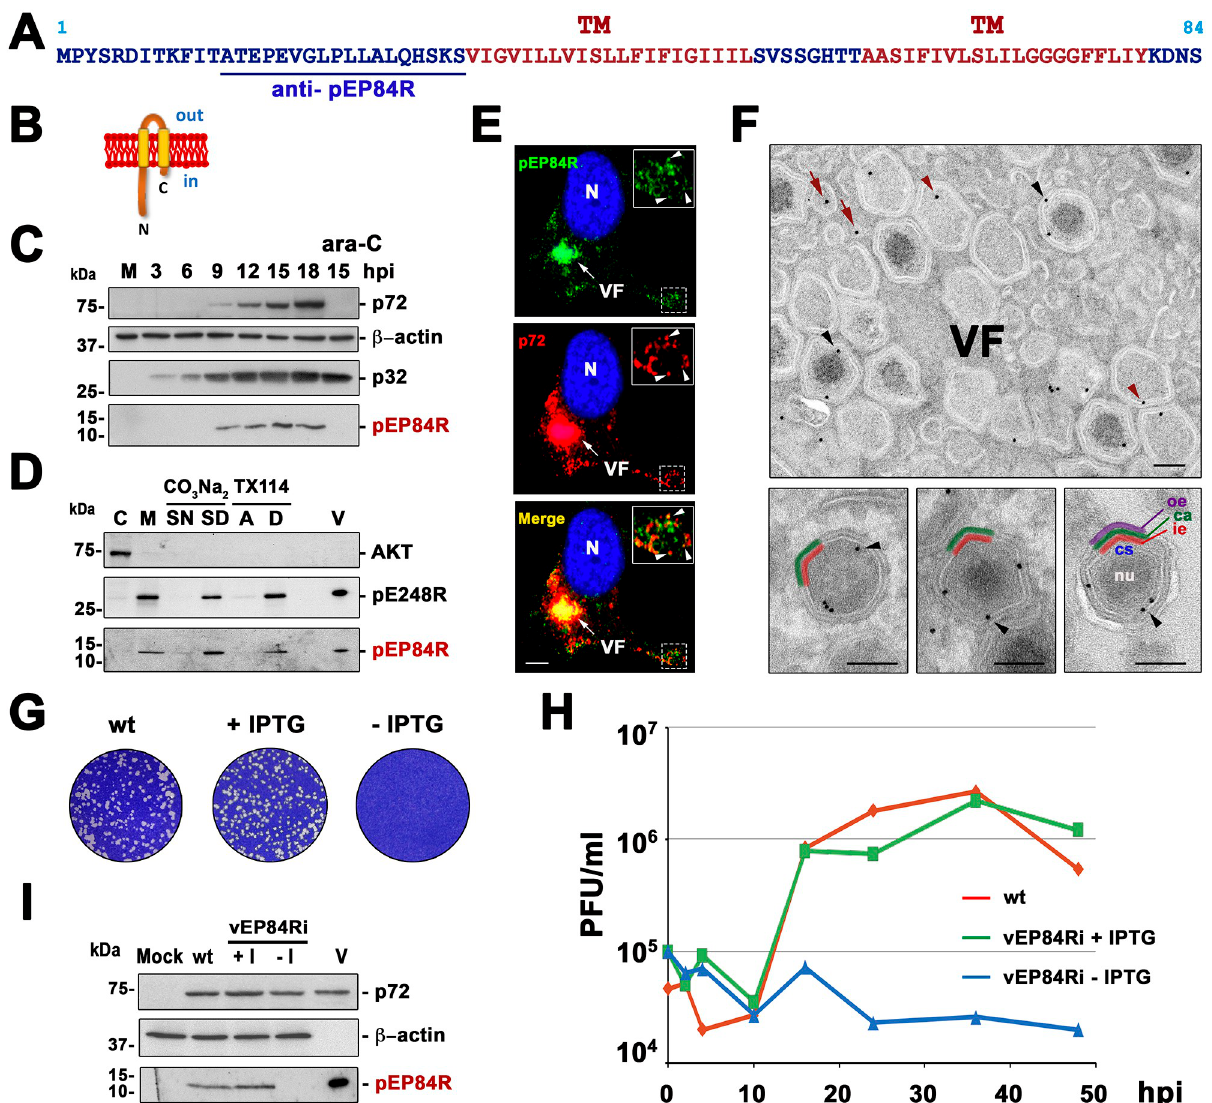
Fig 1. ASFV transmembrane protein pE84R is required for virus replication. (A) Amino acid (aa) sequence of pE84R protein in ASFV BA71V strain. The two putative transmembrane (TM) domains and the peptide sequence used to produce a rabbit anti-pEP84R antibody are indicated. (B) Predicted membrane topology of pEP84R. The N-terminal 30-aa region and the small C-terminal 4-aa tail are predicted to be facing the cytosol (in). (C) Time course of pEP84R expression. ASFV-infected Vero cells were dissociated at the indicated times and analyzed by western blotting for pEP84R along with the early protein p32, the late MCP p72 and ß-actin. Mock (M) and ASFV-infected cells incubated for 15 h in the presence of DNA synthesis inhibitor ara-C were also analyzed. Molecular masses (in kDa) are indicated. (D) Membrane-association of pEP84R protein. ASFV-infected cells were fractionated into cytosolic (C) and membrane/particulate (M) fraction. The latter was subjected to alkaline carbonate (CO 3 Na 2 ) extraction or TX-114 phase separation to obtain supernatant (SN) and sediment (SD) fractions, or aqueous (A) and detergent-rich (D) phases, respectively. Equivalent amounts of each fraction along with purified ASFV (V) were analyzed by immunoblotting with antibodies to pEP84R, cytosolic marker AKT and transmembrane ASFV protein pE248R. (E) Subcellular localization of pEP84R. ASFV-infected cells were fixed at 18 hpi and labeled for pEP84R (green) and MCP p72 (red). Nucleus was stained with Hoechst 33258 (blue). Arrows indicate co-localization at viral factories (VF) while arrowheads in the insets indicate co-localization in scattered virus particles. Bar, 5 μ m. (F) Subviral localization of pEP84R. ASFV-infected cells fixed as above were immunolabelled with anti-pEP84R antibody followed by protein A-gold (10 nm). Note that gold particles in immature (left) and mature (center) virus at the assembly sites, as well as mature extracellular virions (right), are detected at the interface between the core shell (cs, blue), and the inner envelope (ie, red layer). The DNA-containing nucleoid (nu, white), the outer capsid (ca, green) and outer envelope (oe, purple) are also indicated. Bars, 100 nm. (G) Plaque phenotype of vEP84Ri. Vero cell monolayers were infected with BA71V (wt) or vEP84Ri viruses in the presence (+) or absence (-) of IPTG. (H) One-step growth curves of vEP84Ri virus. Vero cells were infected with 5 pfu per cell of BA71V (wt) or vEP84Ri virus in the presence or absence of IPTG. At the indicated hpi the virus titer of each sample was determined. (I) Inducible expression of protein pEP84R. Vero cells were infected as indicated and lysates analyzed along with purified virus (V) by immunoblotting with antibodies to pEP84R, MCP p72 and ß-actin.